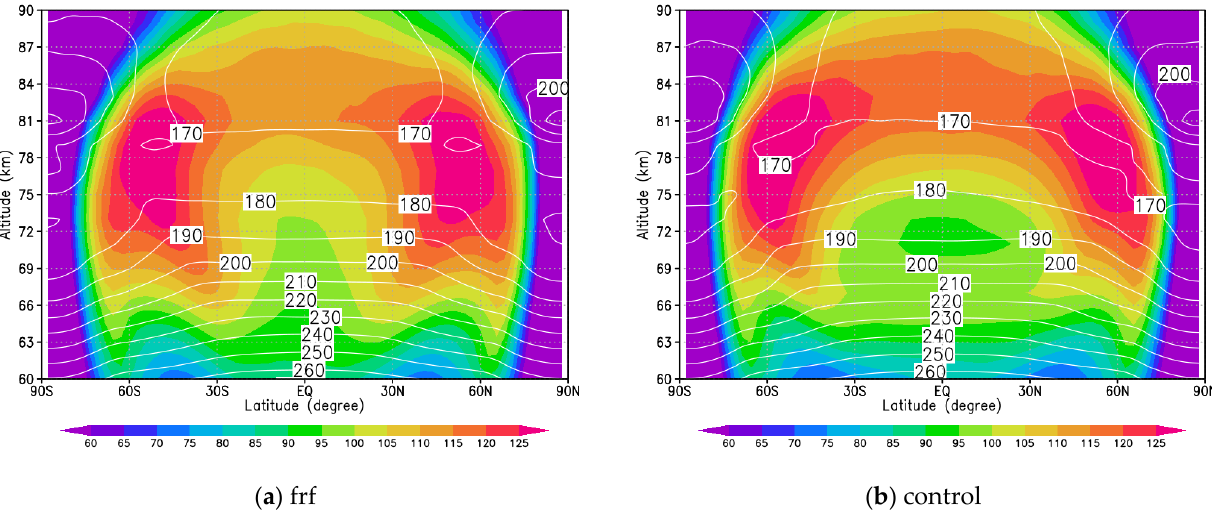
Figure 7. Latitude–altitude cross-sections of zonally averaged zonal wind (m/s; color) and tempera-